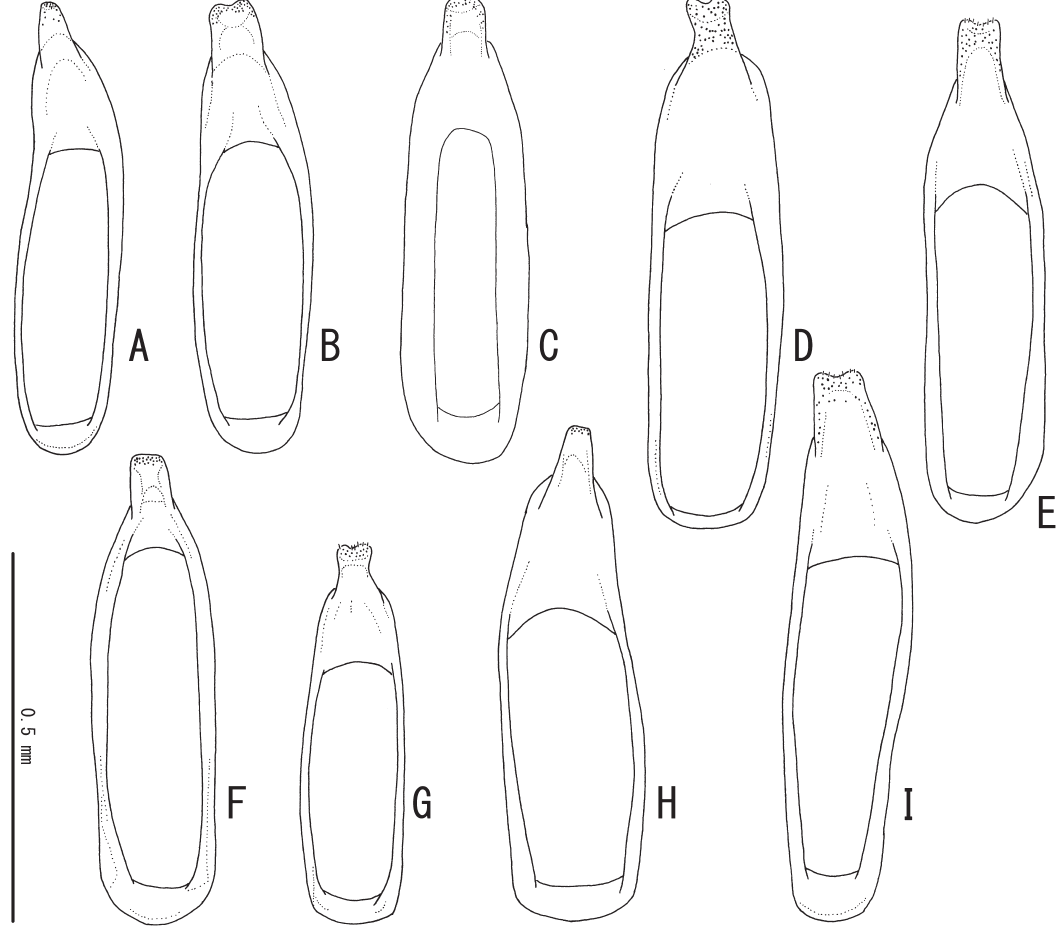
Fig. 9. Aegeagi of Laius spp. A . Laius baliensis sp. nov. (paratype). B . L. andamanensis sp.